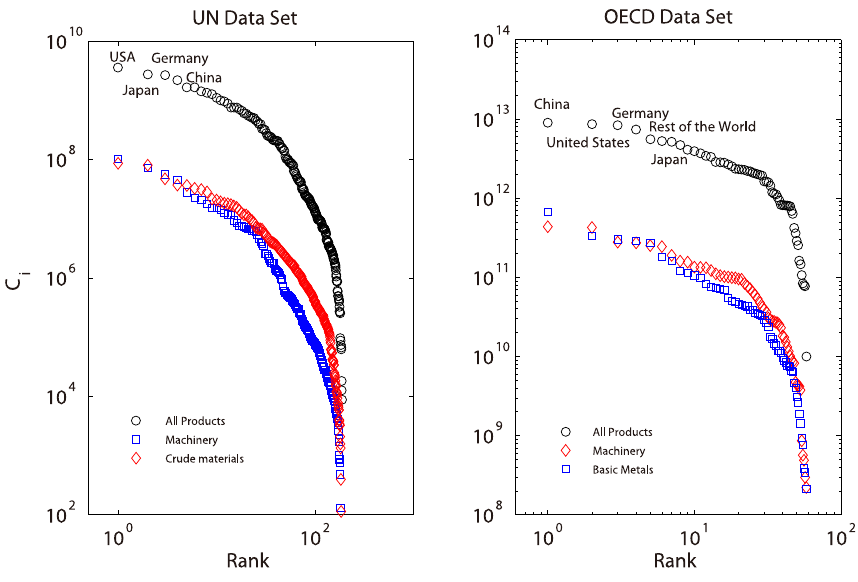
Figure 6. C i Distributions of Both Data Sets. The unit of C i is U.S.dollar.